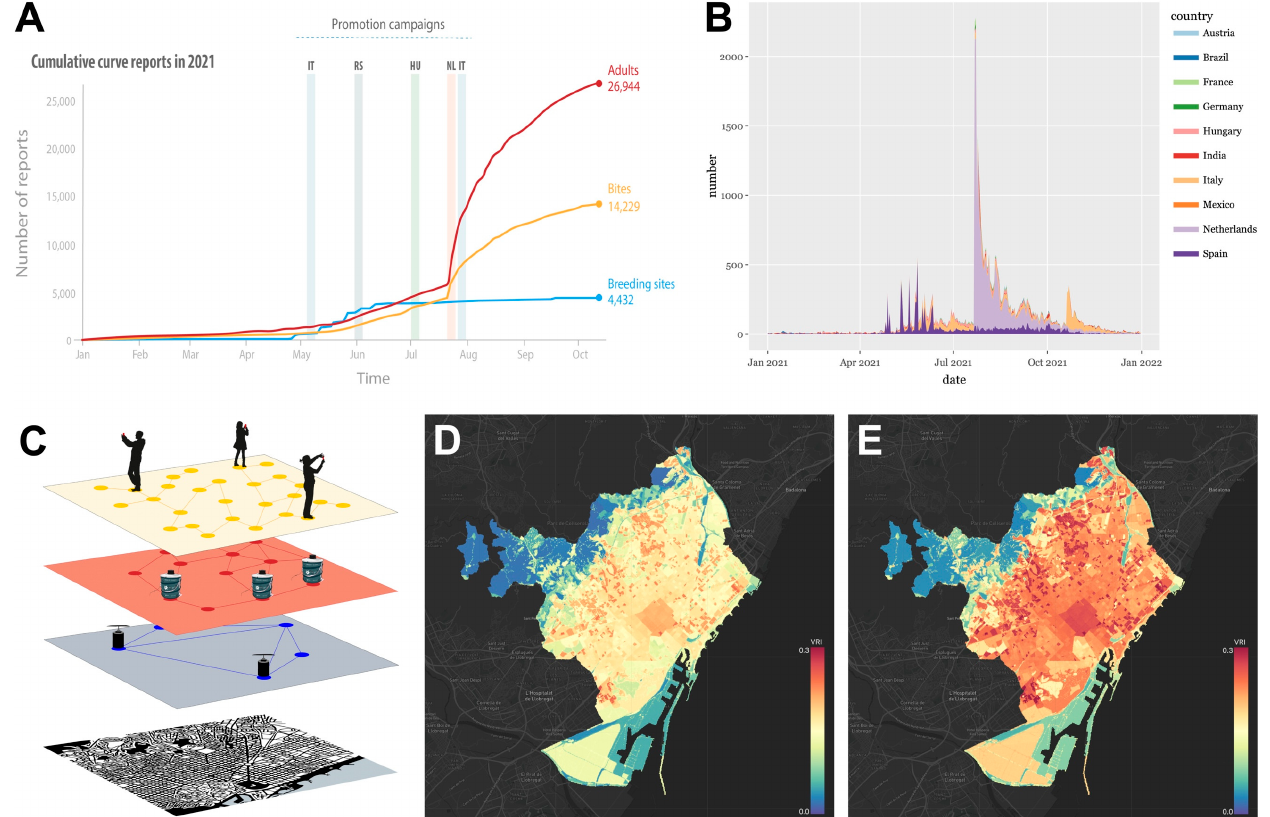
Figure 4. Mosquito Alert reports and risk model. ( A ) Reporting dynamics and sequence of key outreach events in the EU 2021 Mosquito Alert Campaign for Italy (IT), Serbia (RS), Hungary (HU), the Netherlands (NL), and Italy (IT). The success of the Netherlands outreach campaign raised the cumulative number of reports from 5000 to more than 25,000 reports, most of them occurring in a couple of weeks. ( B ) Time series area plot showing the total number of reports over time from the 10 countries with the highest number of reports in 2021. ( C ) Schematic of data layers used to derive Aedes albopictus risk maps. Maps are based on a set of ensemble models that combine Mosquito Alert citizen science data (top) with data from traditional adult mosquito traps and AI-driven smart traps—and also include data on weather, land cover, and sociodemographic characteristics (not shown)—to calculate the vector risk index (VRI) and project it onto a street map layer (bottom). The VRI is a measure of relative risk of human contact with Aedes albopictus , shown here for Barcelona, Spain, on 8 ( D ) and 15 ( E ) September 2021. The live version of this map is available at mosquito- alert.github.io/MosquitoAlertBCN/, accessed on 30 June 2022.